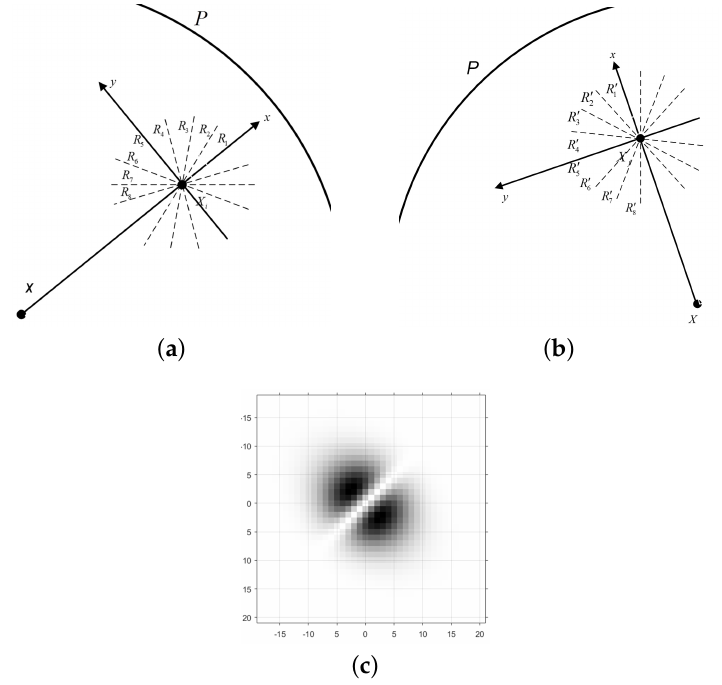
Figure 4. ( a ) Rotation-invariant local coordinate system. ( b ) A rotated example of the local coordinate system. ( c ) A pair of Gaussian-Gamma-Shaped (GGS) windows oriented at π